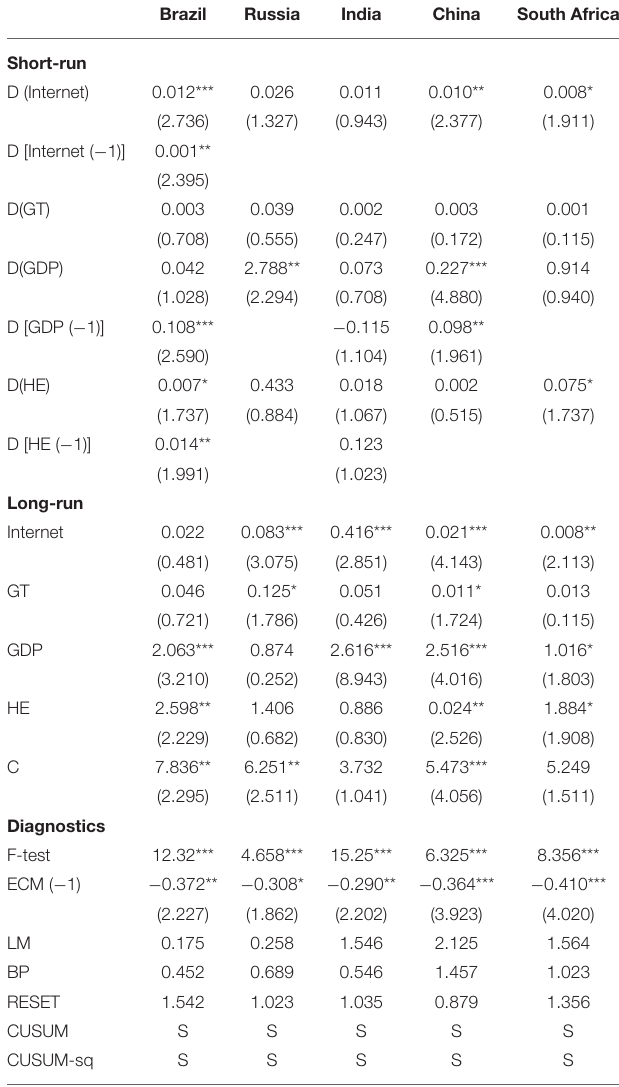
TABLE 3 | ARDL short and long-run